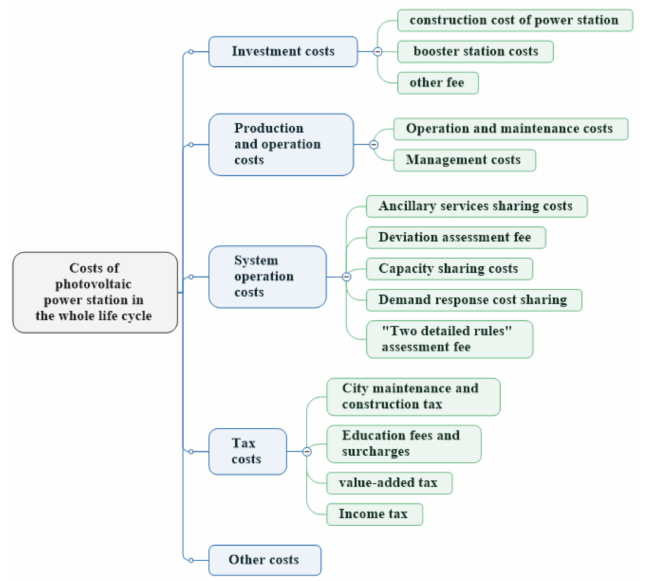
Figure 3. Cost composition of renewable energy power plants participating in the electricity